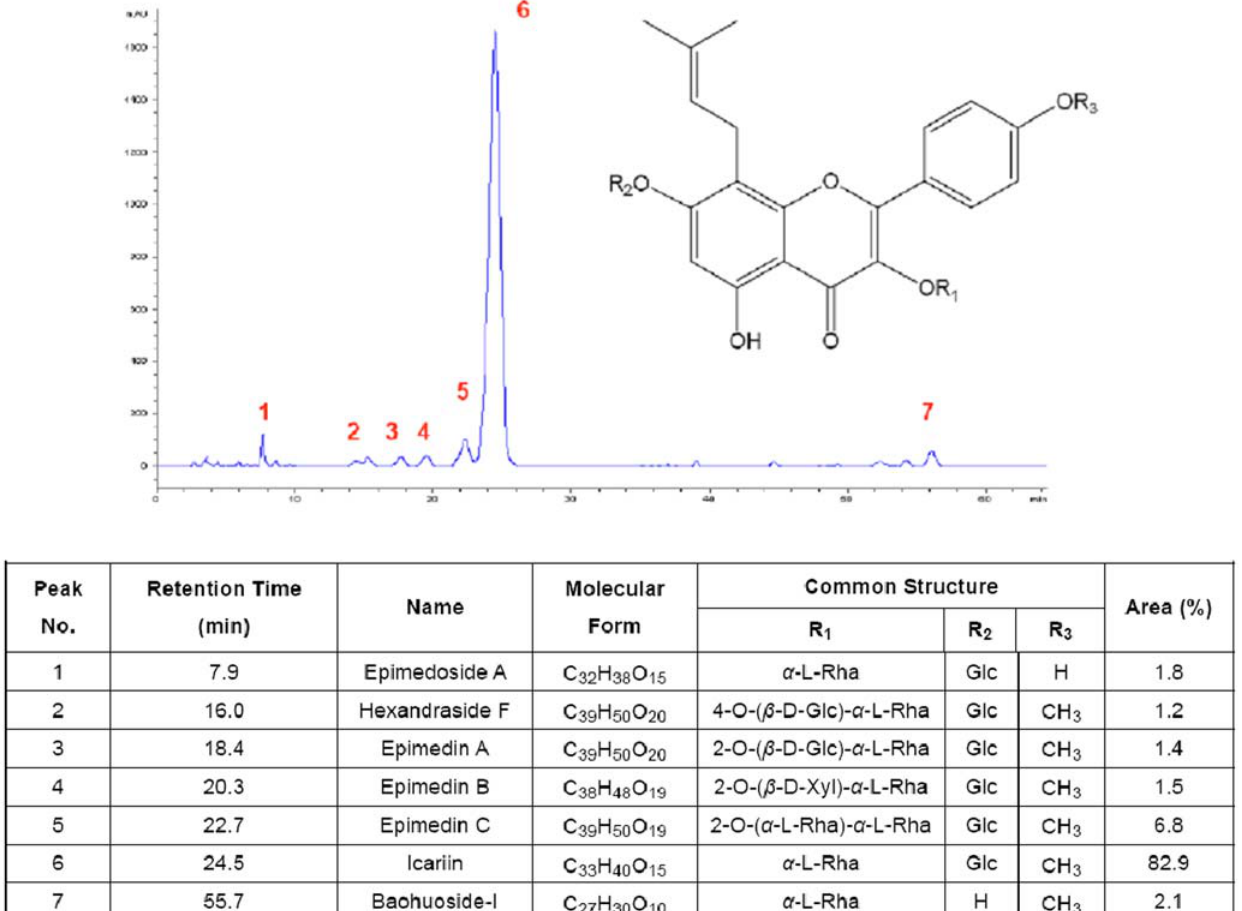
Figure 1. Seven major flavonoid compounds are identified in Epimedium -derived Flavonoids (EF). The common structure is 8- prenylkaempferol. R1 and R2 are substituted by glucose, rhamnose, or xylose, and R3 is replaced by methyl.